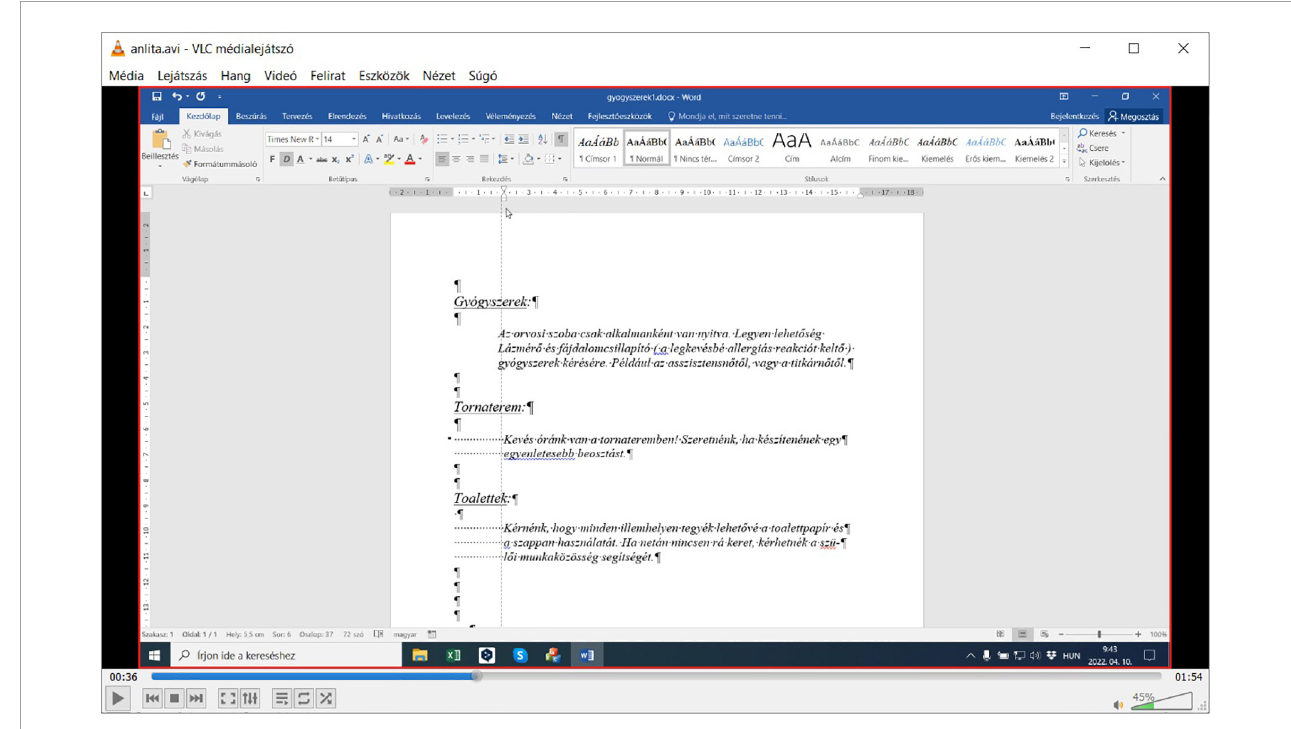
FIGURE12 Video playback of what ANLITA (FFmpeg) recorded when Figure 11 was logged.